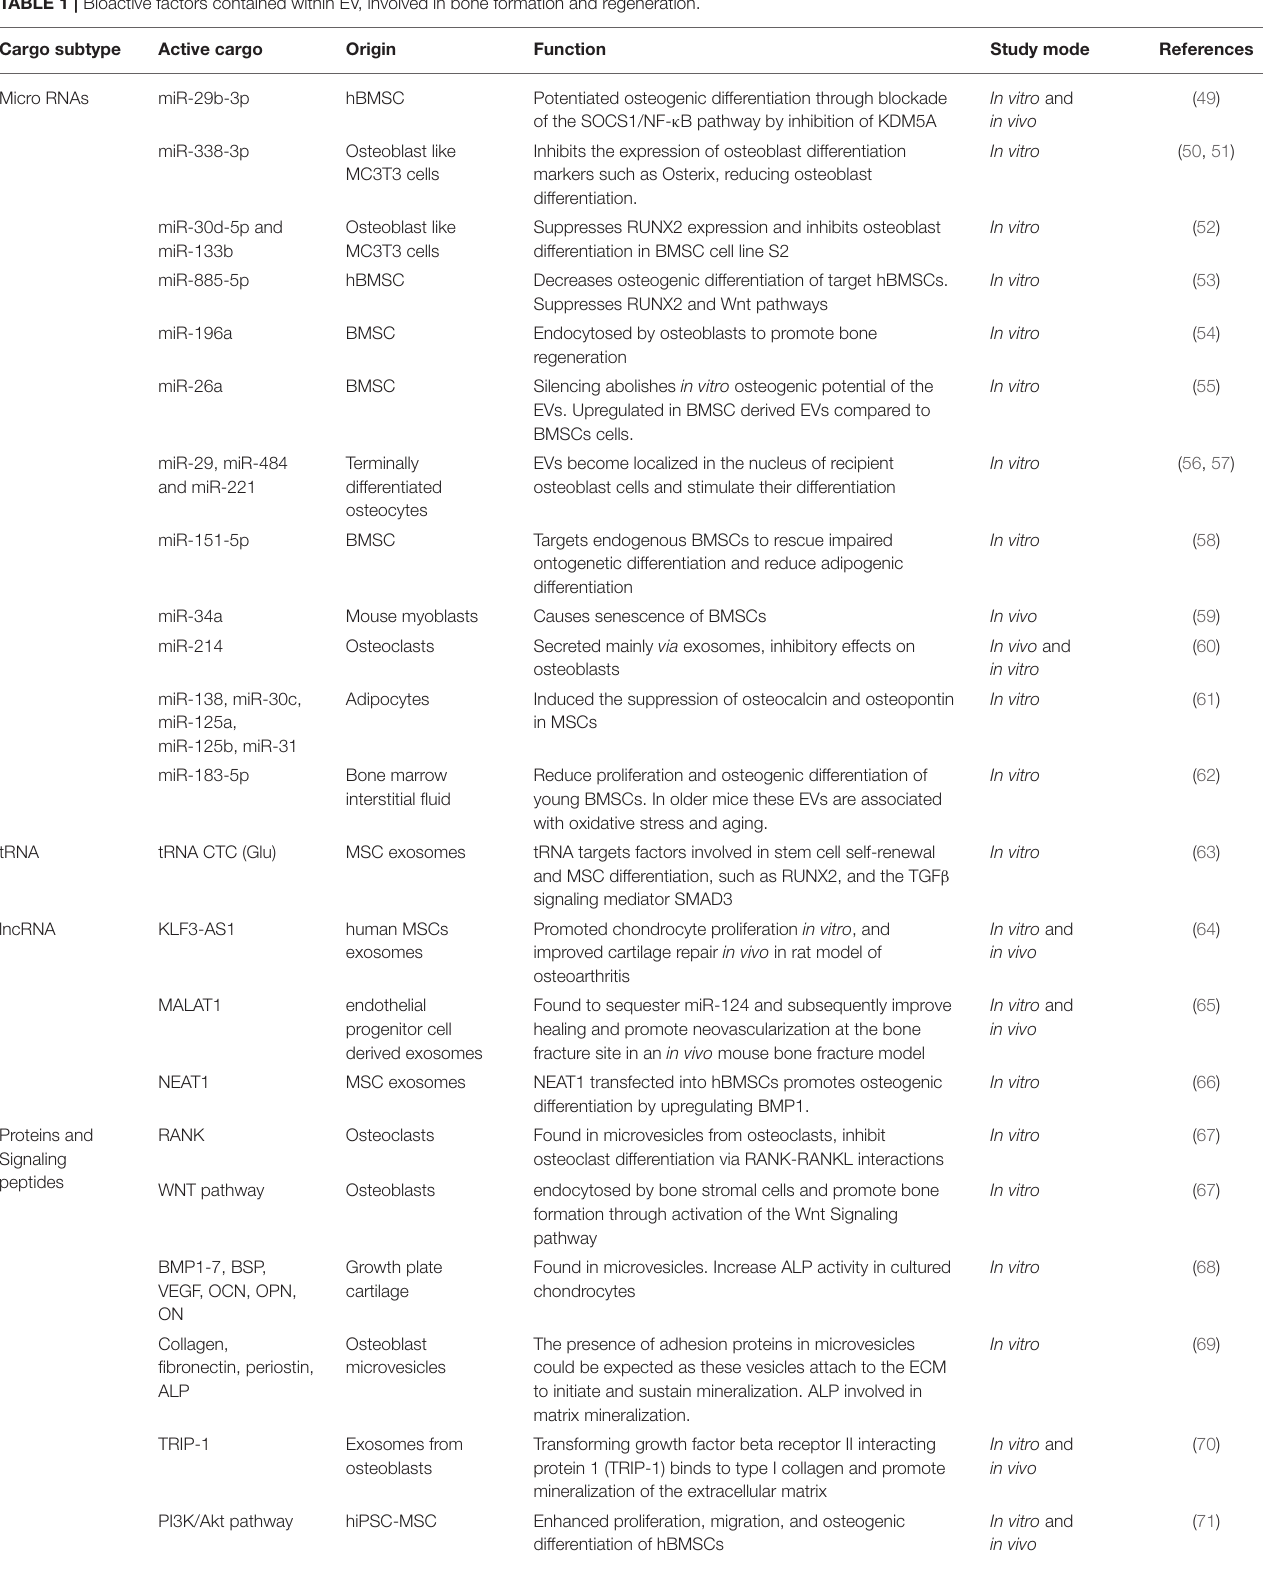
TABLE 1 | Bioactive factors contained within EV, involved in bone formation and regeneration. Cargo